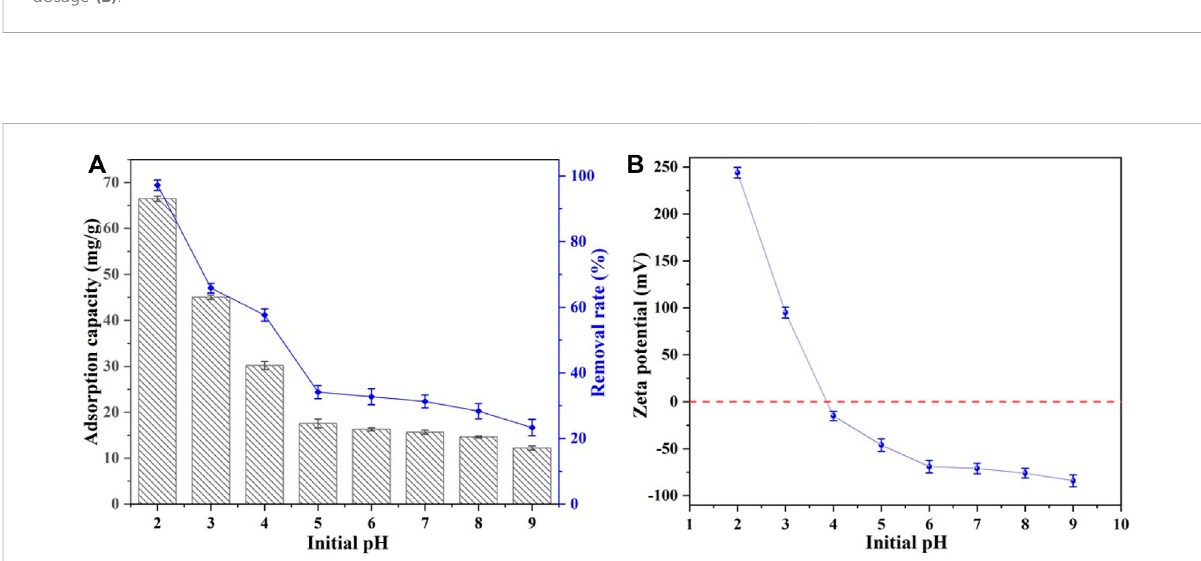
et al., 2022a). This indicates the positively charged adsorbent surface under acid conditions, which further bene fi ts the attraction of SeO 3 2- oxyanions. The maximum capacity of Se(IV) contaminants was 66.47 mg/g with pH 2. However, this severe acid situation barely exists in conventional water surroundings — Se-containing wastewater is generally acidic to weakly alkaline (3.0 – 8.0) (Zhang L et al., 2022). Hence, the initial solution pH in the following sections was set as 4. Therefore, electrostatic attraction could be one of the removal mechanisms, while more inter-surface reactions could be elucidated by thermodynamics